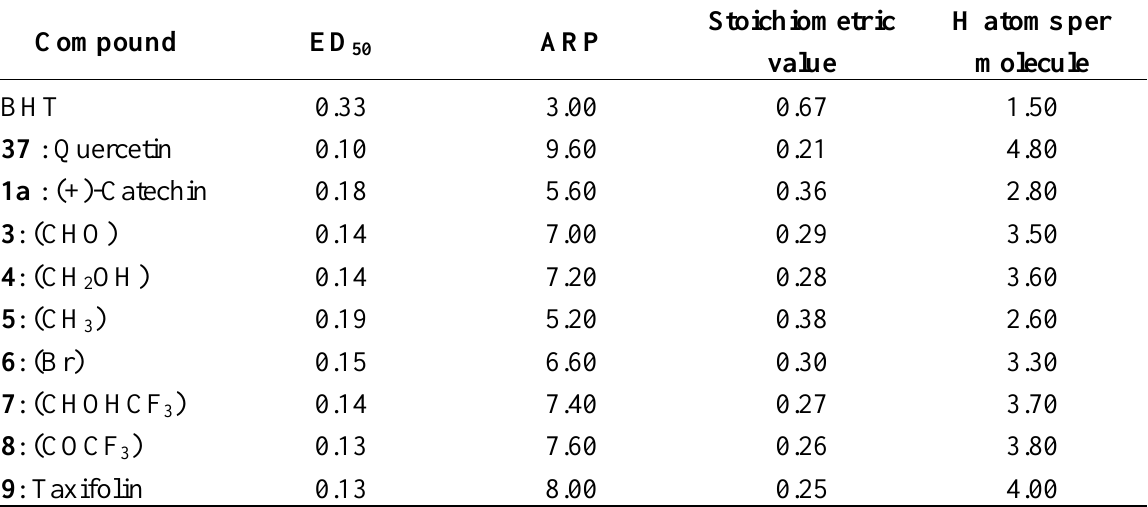
Table 1. Antiradical power and stoichiometry from the DPPH